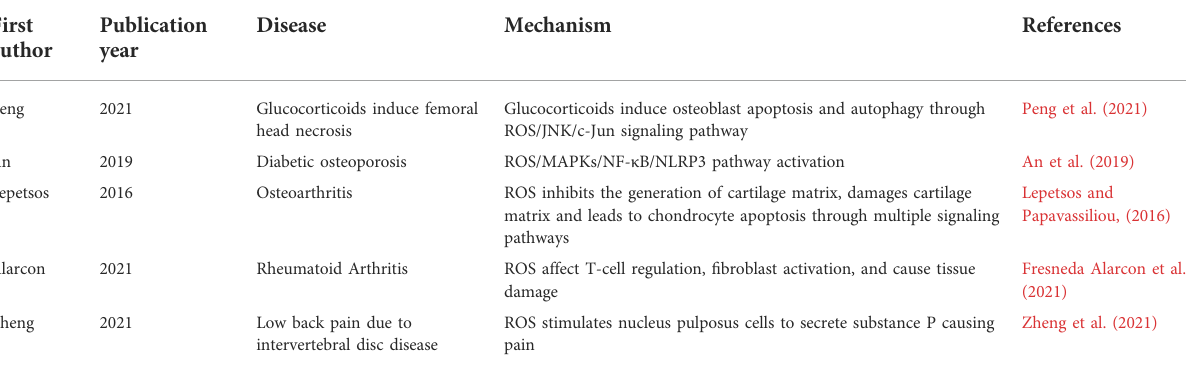
TABLE 1 Some representative studies on the association between ROS and the occurrence and development of orthopaedic